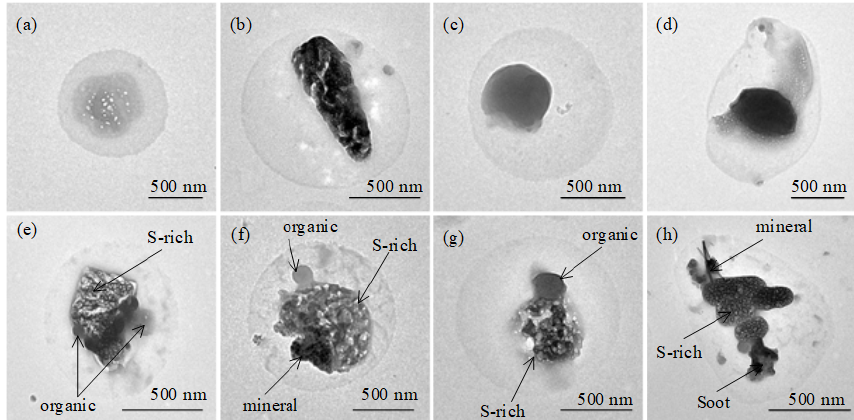
Figure 4. Images of core–shell-structured particles. (a–b) S-rich cores, (c–d) organic cores, and (e–h) mixed cores.